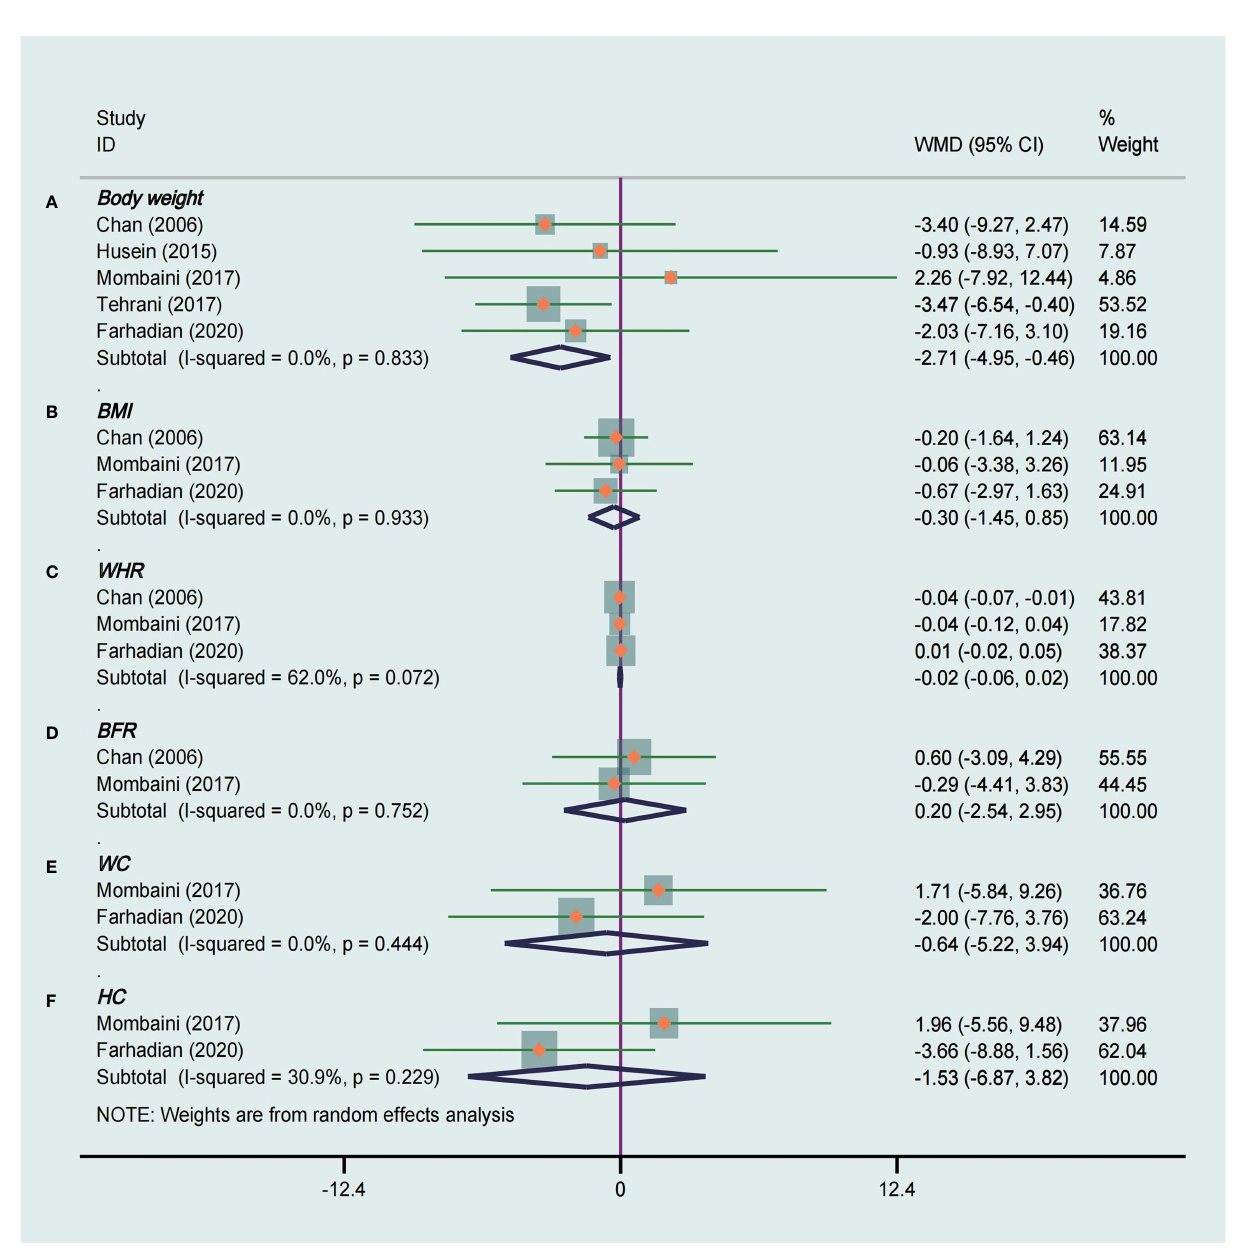
FIGURE 3 | Meta-analyses of the effect of tea supplements on anthropometric parameters. (A) Body weight, (B) BMI, (C) WHR, (D) BFR, (E) WC, and (F) HC.